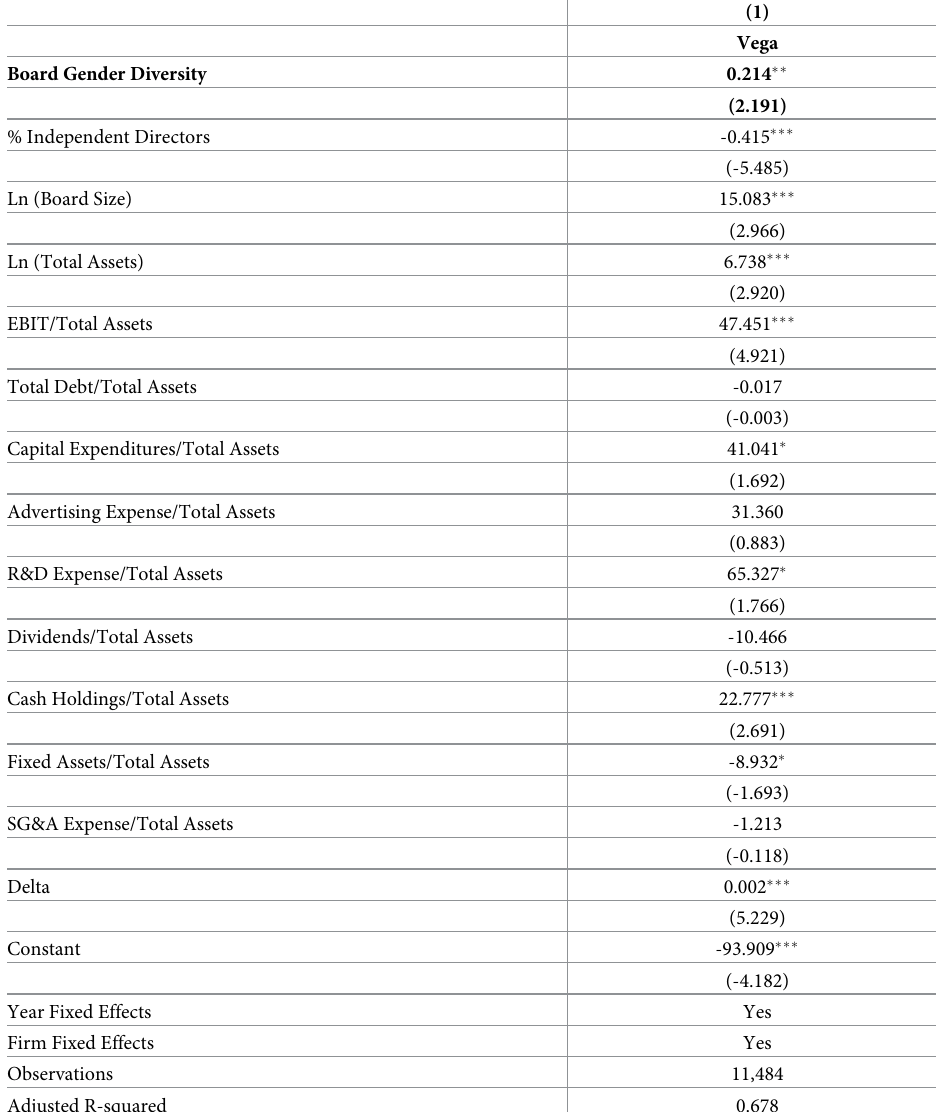
Table 4. Entropy